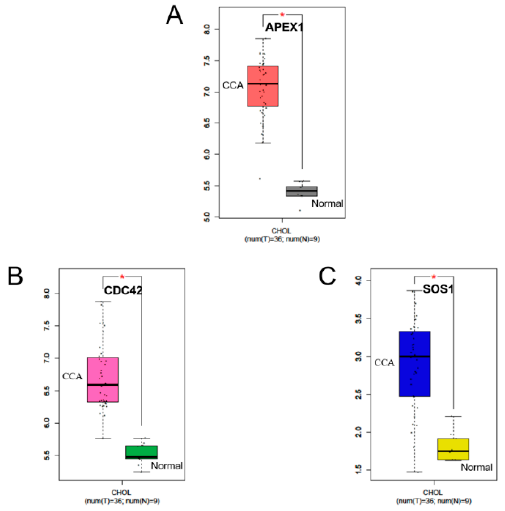
Figure 6. Box diagram of the expression of the RNA level between CCA and normal tissues. Image